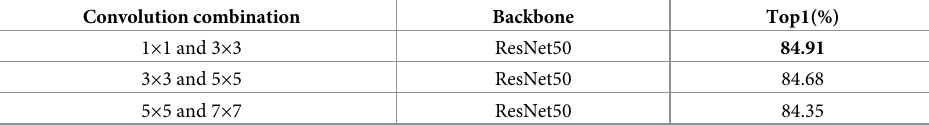
Table 3. Top1 accuracy (%) of convolution combinations with different sizes on CUB-200-2011.